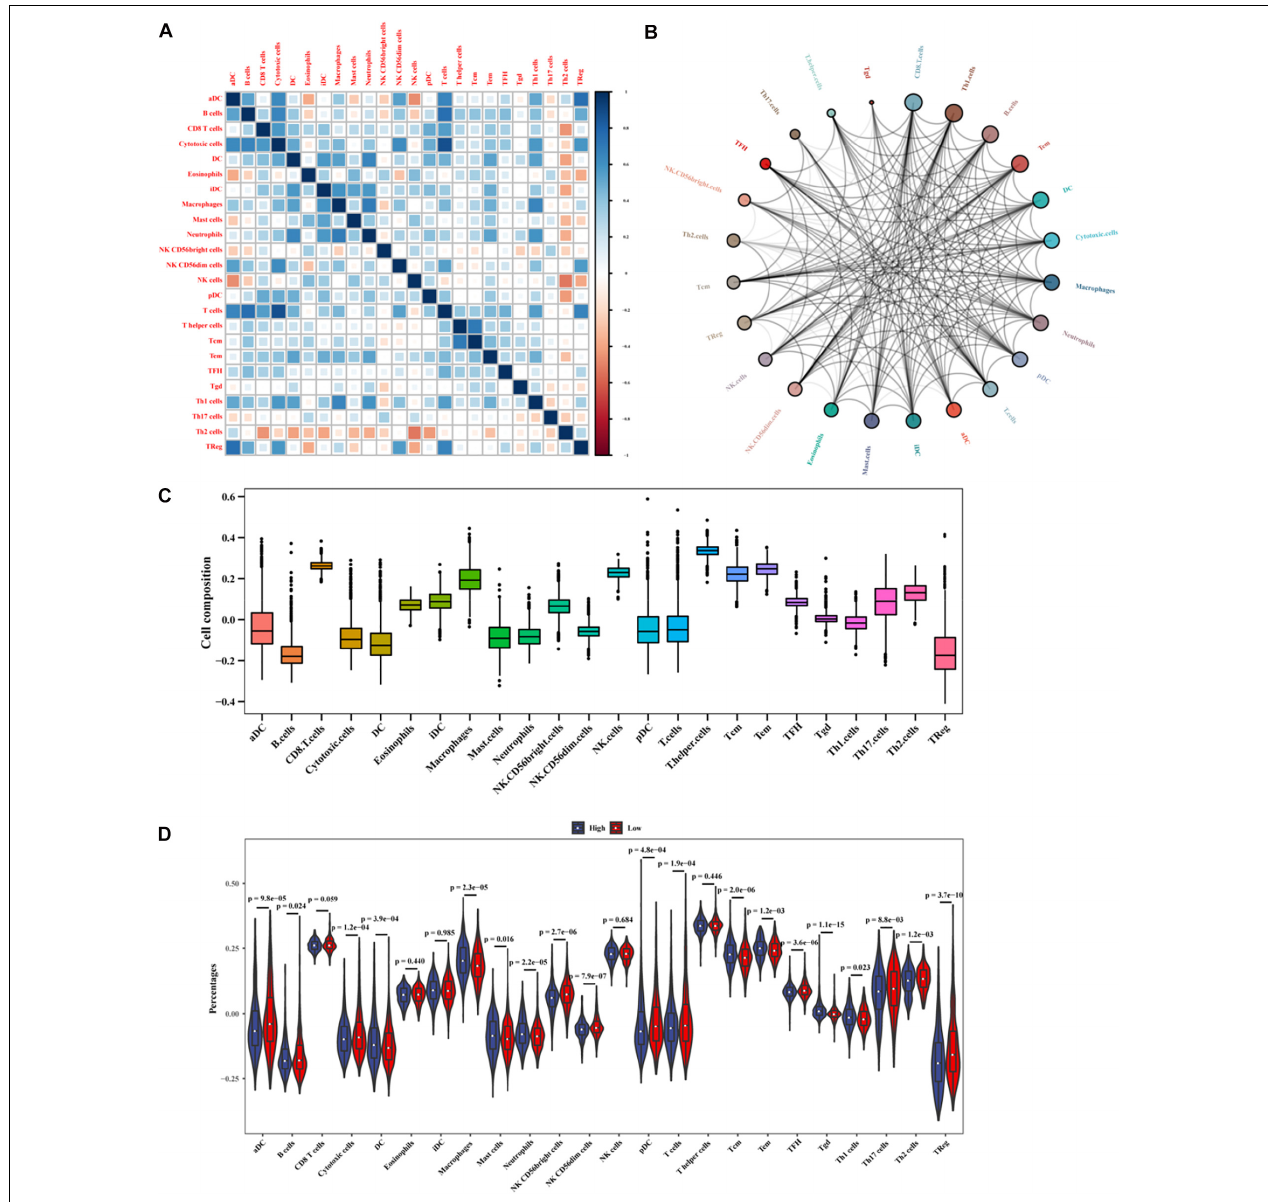
FIGURE 11 | Analysis of immune cell infiltration in BC patients. (A) The correlation between infiltrating immune cells. (B) The cycle indicates the immune cell-cell interactions in the tumor microenvironment in BC. A larger circle corresponds to more interactions between immune cells and vice versa. (C) The x -axis represents immune cell types, and the y -axis represents the percentage of immune cells. (D) The differences in the expressions of infiltrating immune cells between the high- and low-risk